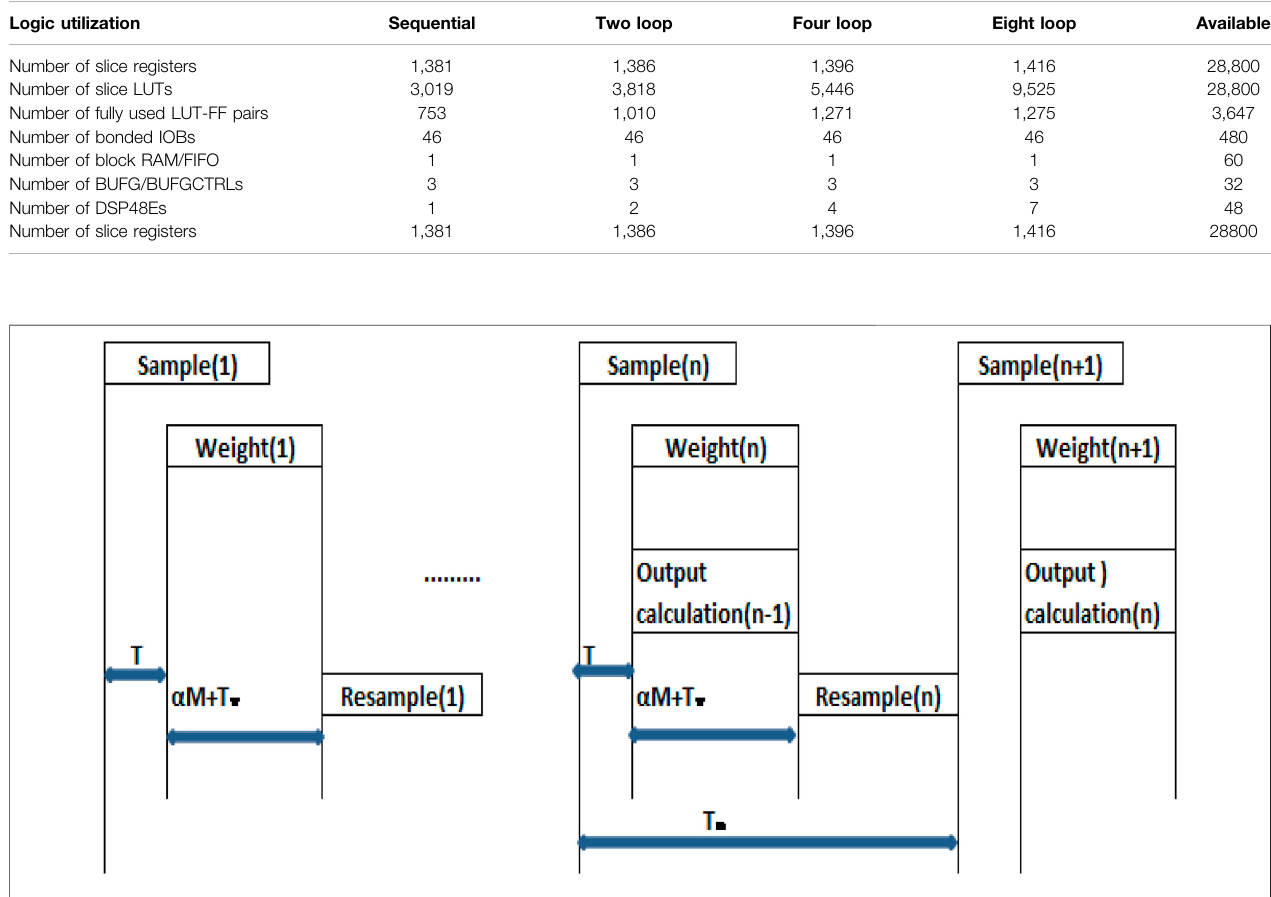
FIGURE 14 | The timing diagram for the SIRF